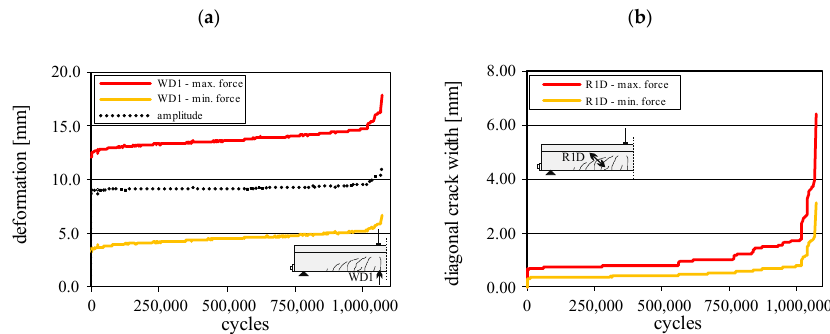
Figure 4. Development of ( a ) deflection and ( b ) indication of crack width with increasing load cycles for test T-33-2a.